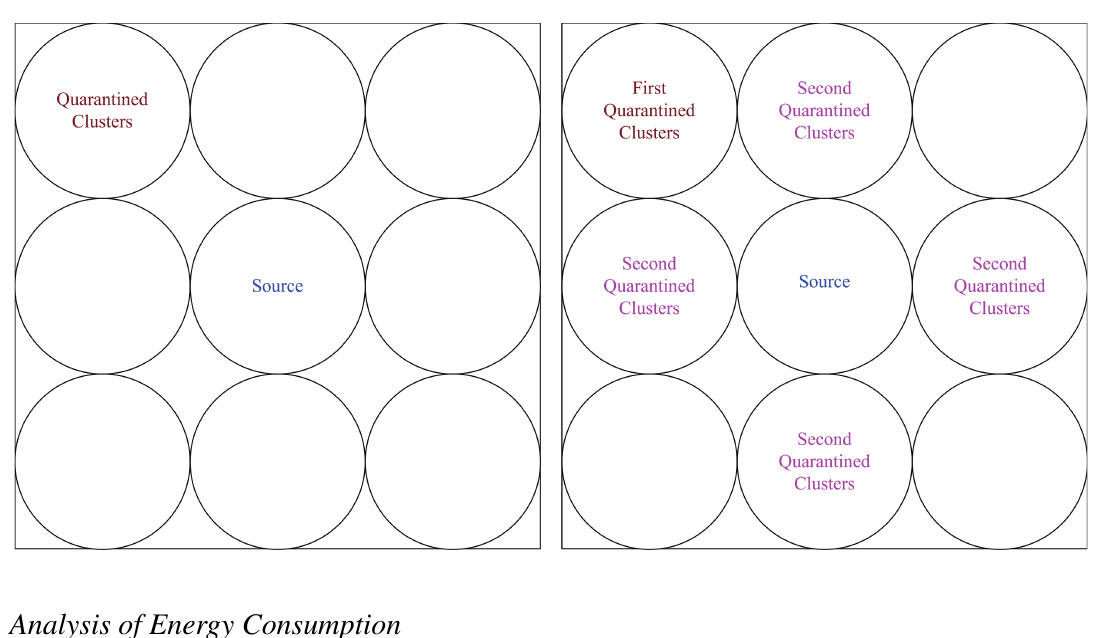
Figure 10. The locations of quarantined clusters given the location of source group 3; one cluster quarantined (left), two clusters quarantined with possible locations of the second quarantined cluster